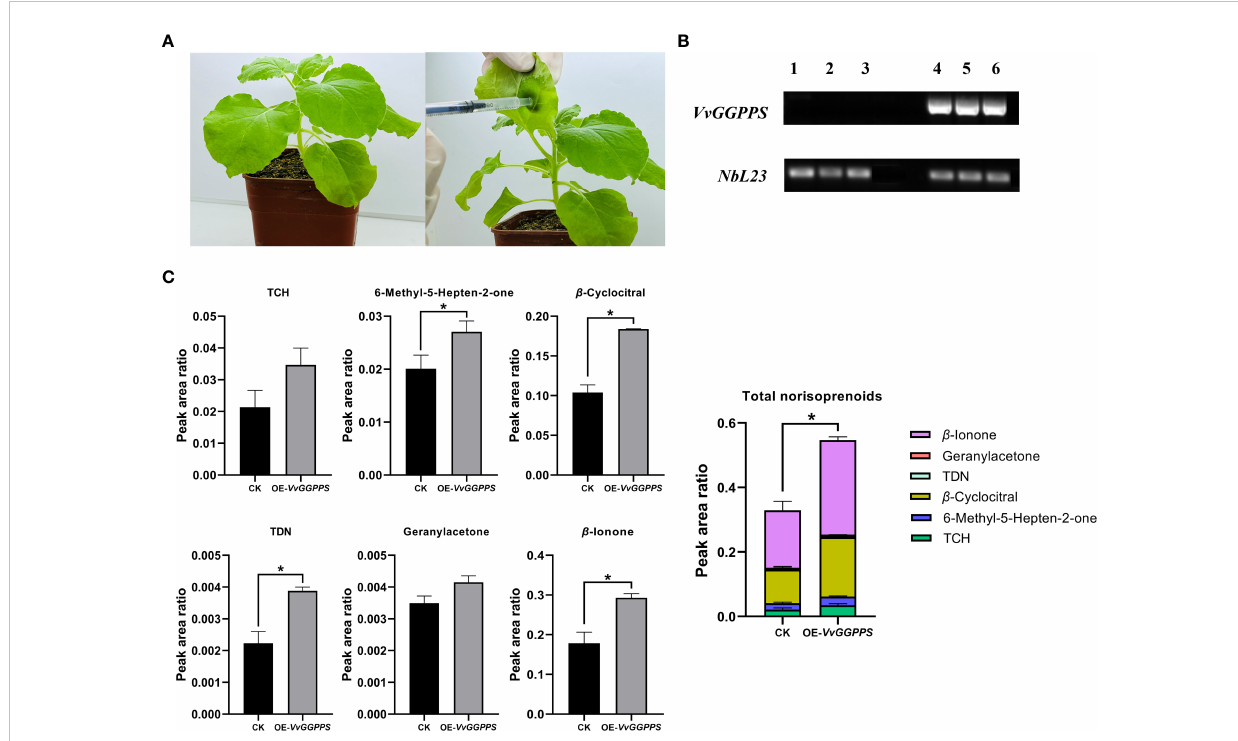
FIGURE 7 Functional analysis of VvGGPPS in the leaves of tobacco ( Nicotiana benthamiana ). (A) Pictures displaying normal wild-type (left) and injected (right) leaves of N. benthamiana. (B) RT – PCR analysis of VvGGPPS expression. The original fi gure is shown in Supplementary Figure S5. NbL23 was used as the internal reference gene. Lanes 1 to 3 on the electrophoretic gel represent control groups; Lanes 4 to 6 on the electrophoretic gel represent overexpressed VvGGPPS groups. (C) Concentrations of norisoprenoid compounds detected in the leaves of tobacco. CK represents the control groups from wild-type leaves; OE- VvGGPPS represents the overexpressed VvGGPPS groups from injected leaves. The asterisks * indicates signi fi cant levels at p